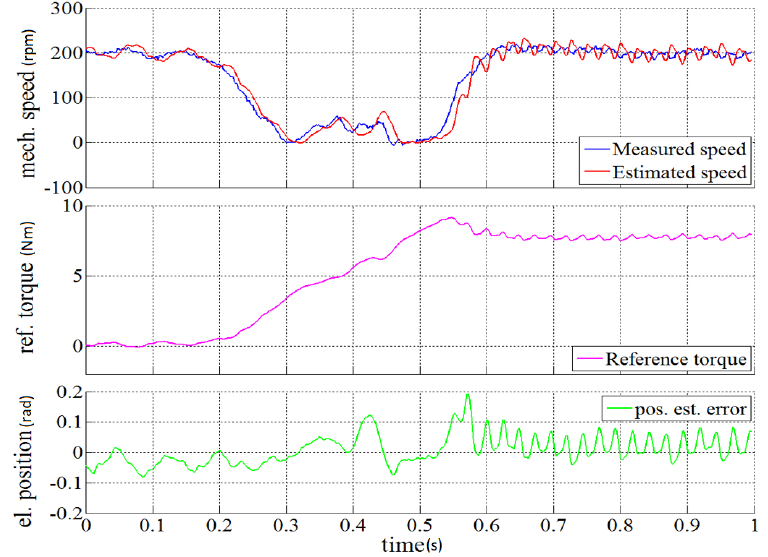
Figure 14. Motor #1: Sensorless speed control (MTPA), load disturbance at 200 rpm, 0 to 6 Nm load, typical (no-adaptation) rotating voltage injection.